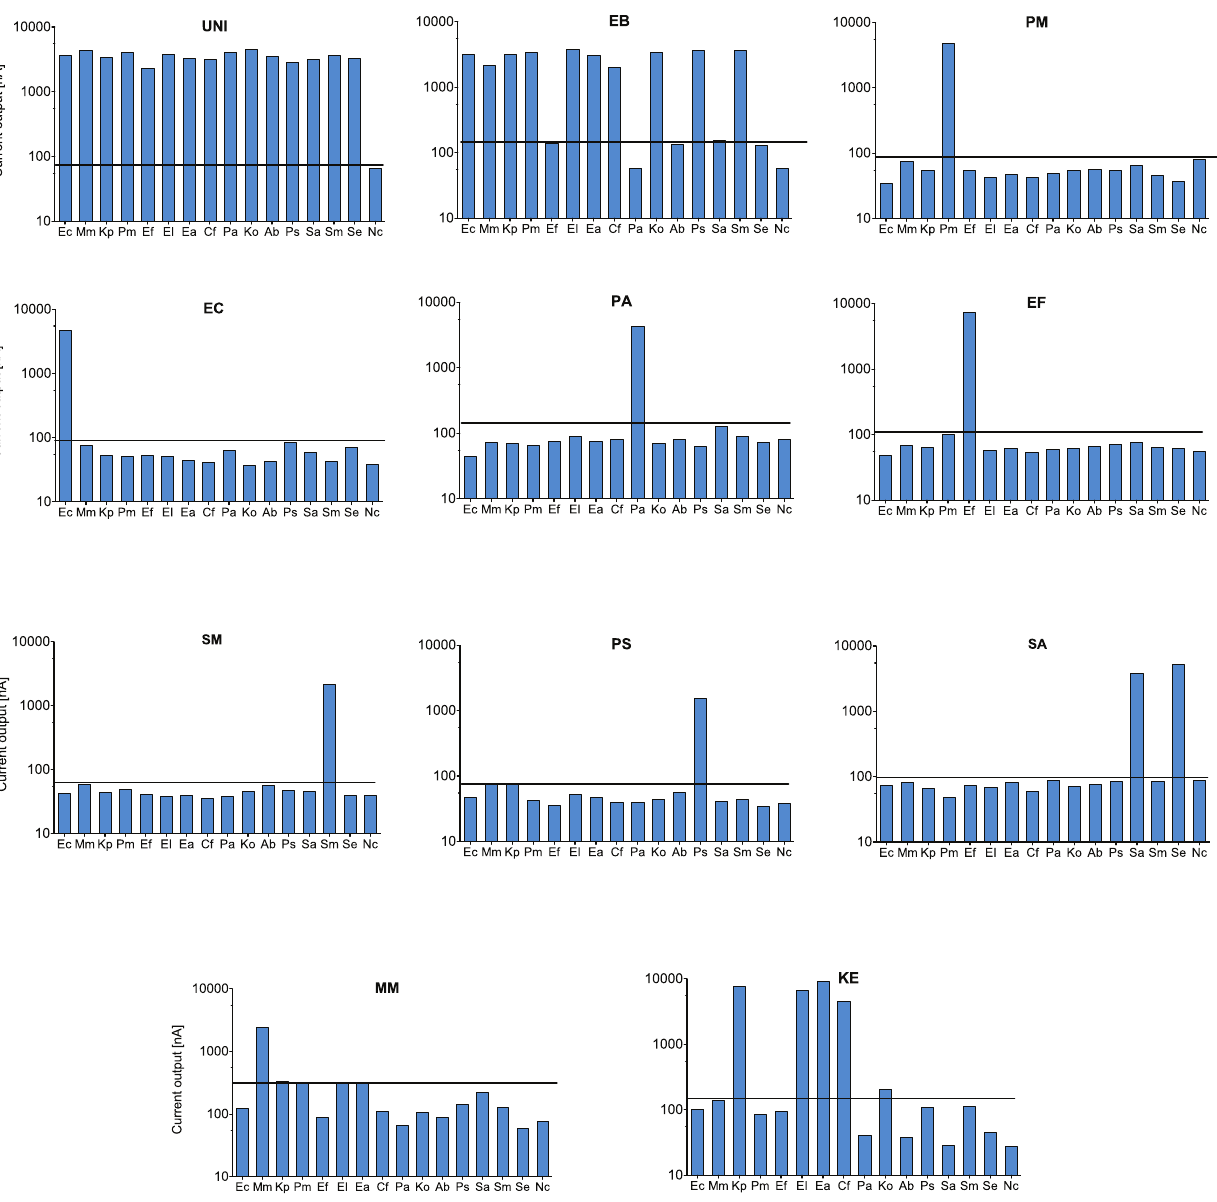
Figure 3. Specificity of biosensor pathogen detection with 20–24 bp oligonucleotide probes designed for hybridization at 37 6 C. Log signal intensities of current (nA) are plotted on the Y-axis. Common uropathogens tested are indicated on the X-axis. The line over the bars indicates the threshold for positive biosensor signal 3SD (log 10 unit) over the negative control for UNI, EB, PM, EC, PA, EF, SM, PS, SA and 5SD (log 10 unit) over negative control for MM and KE probes. Consistent with their in silico design, UNI probe pair detected all bacterial species and EB probe pair detected members of Enterobacteriaceae . PM, EC, PA, EF, SM, PS, SA and MM probe pairs specifically detected Proteus mirabilis , E. coli , Pseudomonas aeruginosa , Enterococcus spp., Serratia marcescens , Providencia spp., Staphylococcus spp, and Morganella morganii , respectively. The KE probe pair detected Klebsiella pneumoniae , Klebsiella oxytoca , Citrobacter freundii , Enterobacter aerogenes and Enterobacter cloacae . Probe sequences are provided in Table